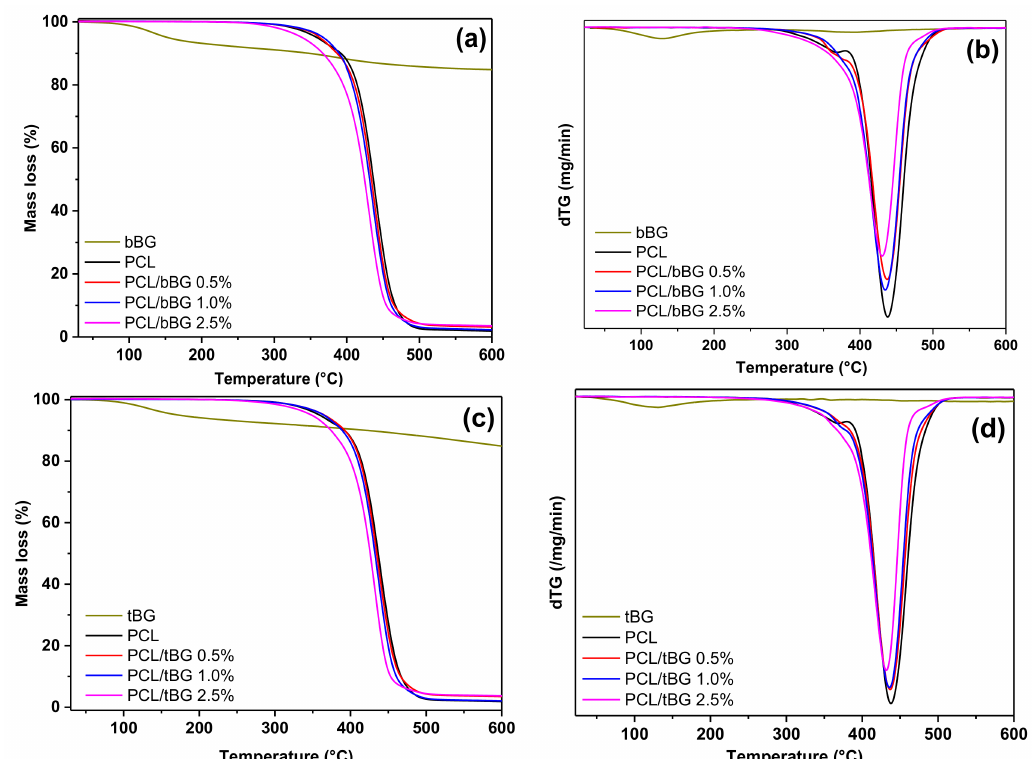
Figure A2. ( a , c ) Mass loss curves and ( b , d ) DTG curves of PCL/bBG and PCL/tBG